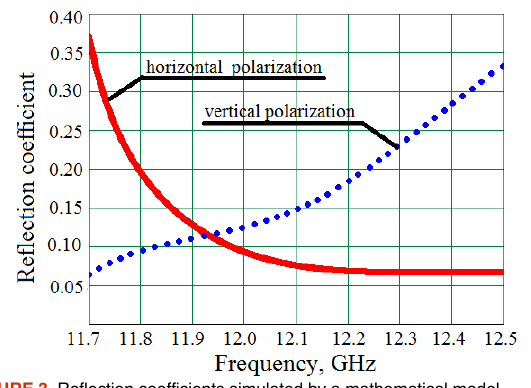
FIGURE 3. Reflection coefficients simulated by a mathematical model. Fig. 4 demonstrates that module of the transmission